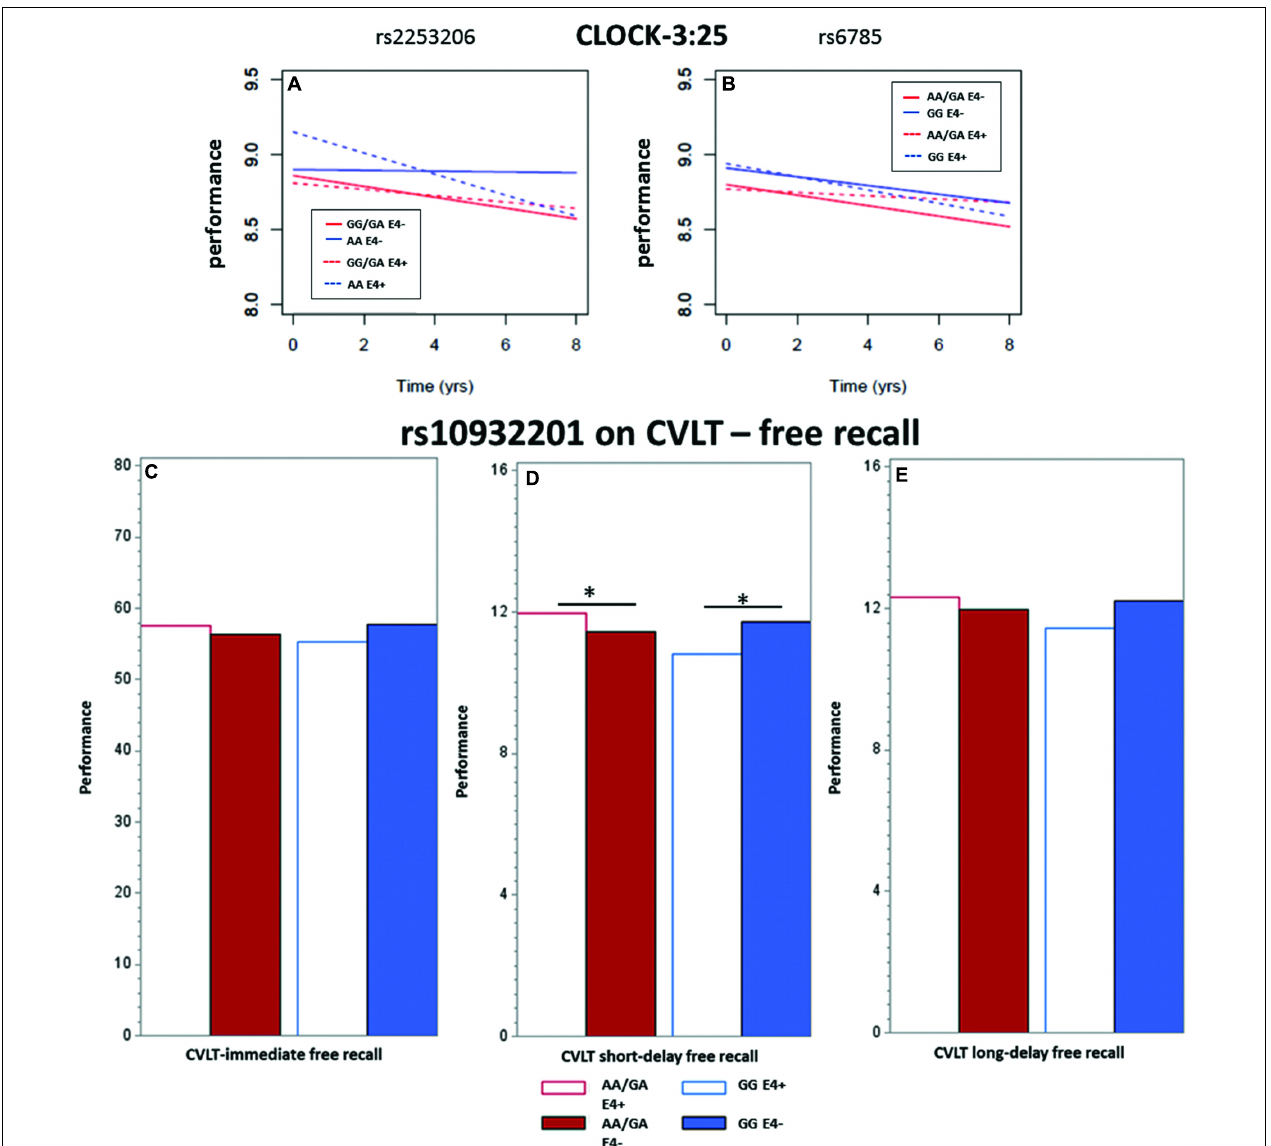
FIGURE 2 | Showing the significant interactions between CREB1 SNP genotypes and APOE ε 4 status on the longitudinal population-average trajectories for executive function and memory performance (A,B) CLOCK-3:25 based on the predicted values after adjusting for baseline age, sex and education, and on population-average cross-sectional memory performance (C) immediate recall, (D) short-term and (E) long-term episodic memory based on the predicted values after adjusting for baseline age, sex, and education. All the effects were estimated using LME models except for CLOCK measures where GEE models were used. ∗ indicates significance at p =